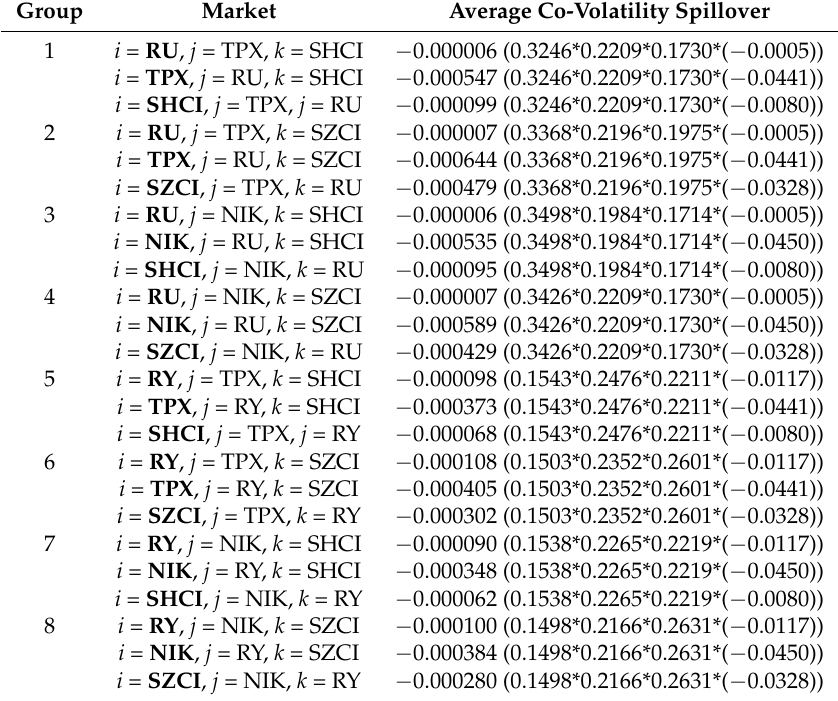
Table 7. Co-Volatility Spillover